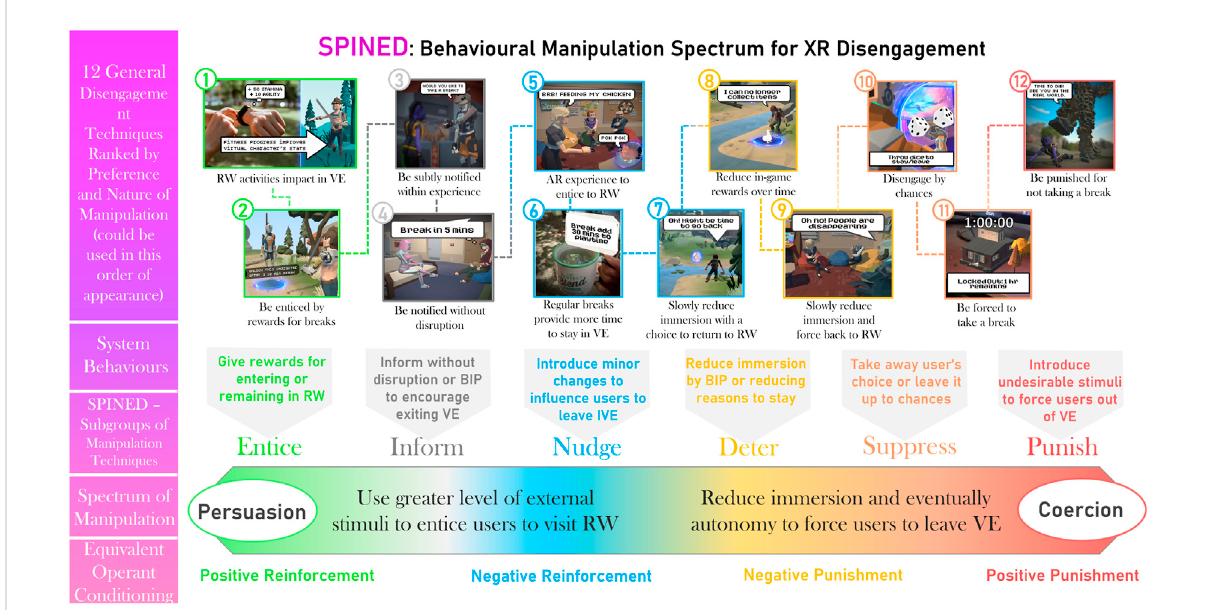
FIGURE 14 SPINED — A behavioural manipulation spectrum for XR disengagement to help guide the design of disengagement techniques and strategies. From top to bottom, 12 general disengagement techniques were arranged based on their ranking result and types of manipulation. The common system behaviours were drawn from the common cluster based on the types of manipulation employed. This yielded the six SPINED subgroups. A spectrum between persuasion and coercion was derived from the nature of the subgroups and their strategies relative to the two extremes to entice or force the users by adding or removing stimuli. Such observations could then be mapped back and explained by operant conditioning